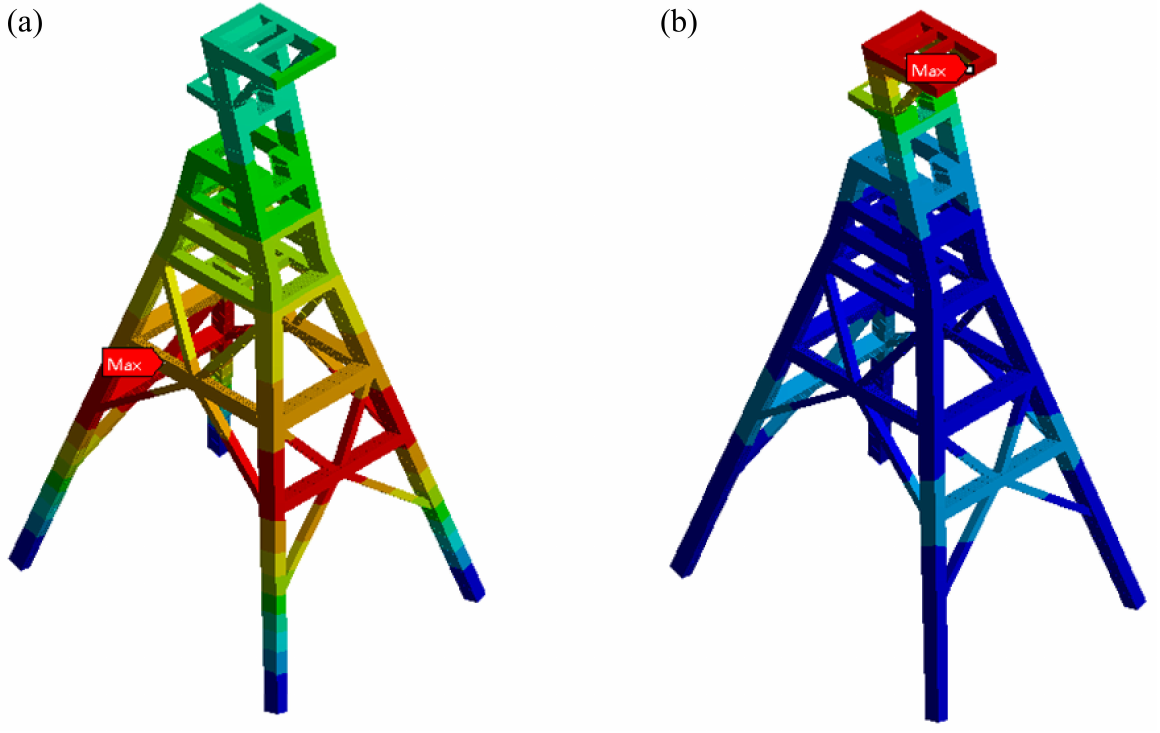
Figure 6. The overall vibration modes of the large headframe. ( a ) The mode under an alternating load of 1.9 Hz. ( b ) The mode under an alternating load of 2.7